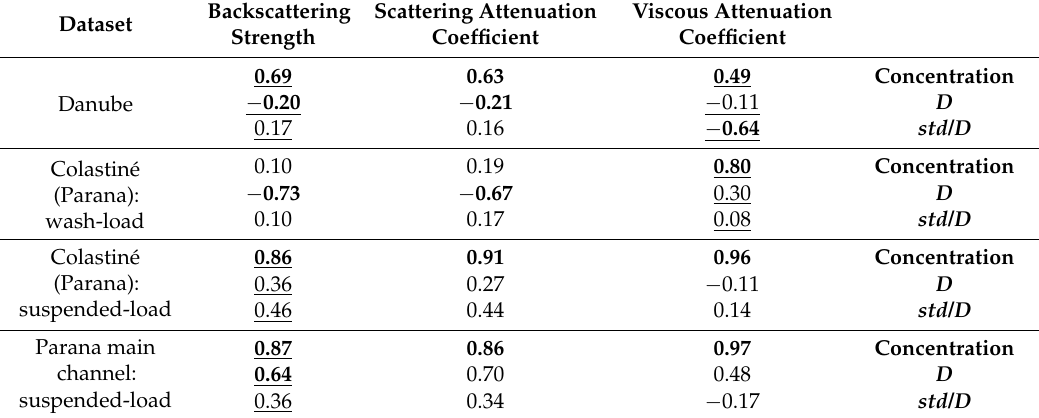
Table 3. Correlations among acoustic variables (reported in the first line) and corresponding sediment features ( i.e. , concentration, D and std/D ) for different datasets (from Danube and Parana rivers); note that the statistically significant correlations are reported with a bold font and underlined font is used for correlations corresponding to most relevant acoustic features, which are the assessed backscattering strength with appreciable variation (5–20 dB) and viscous attenuation with moderate-high magnitude (0.1–0.4 dB/m) as reported in Figures 10 and 11.